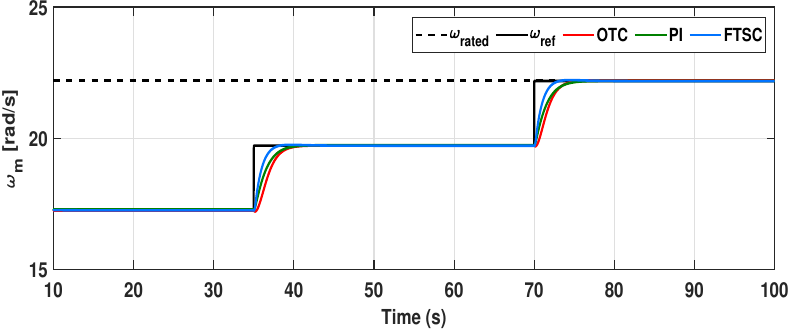
Figure 8. Dynamic response of rotor speed under the proposed FTSC scheme in comparison with OTC and PI controllers under step wind profile.